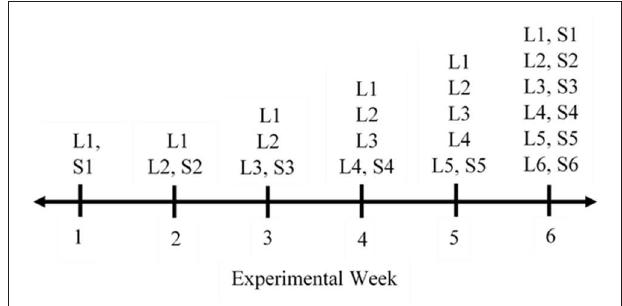
FIGURE 2 | This timeline graphic outlines the measurements taken over the period of 6 weeks for each steer. Data collected are defined as follows: L# (1–6), hair length for the specified area was measured in the rump region; S# (1–6), hair sample for the specified area was